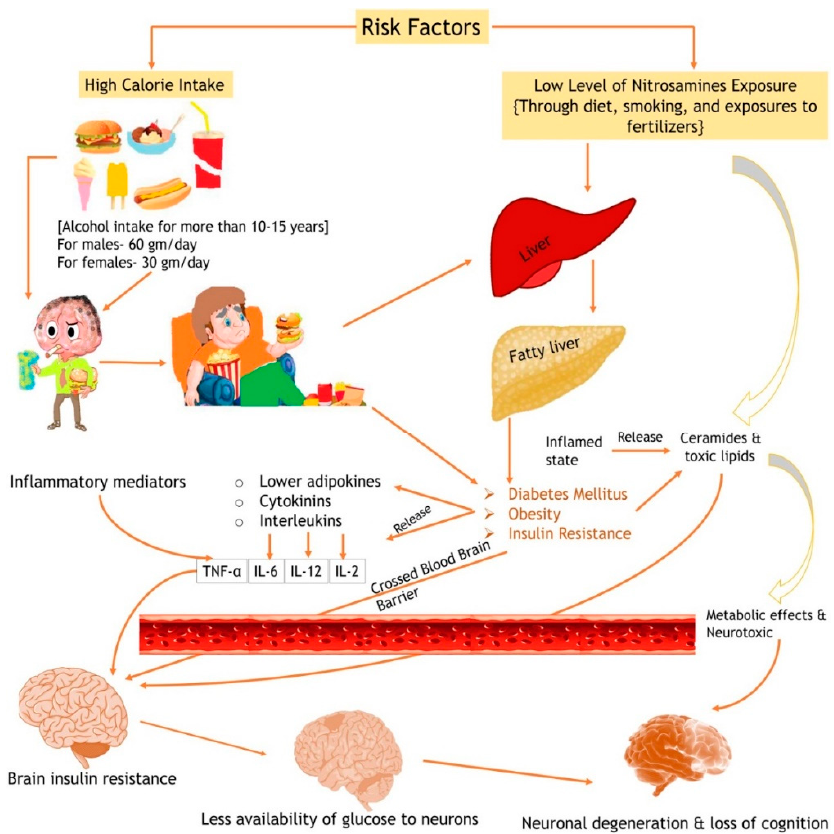
Figure 1. Pathophysiology of insulin resistance, metabolic malfunction, and progression to a neurological disorder. TNF, tumor necrosis factor; IL, interleukin.